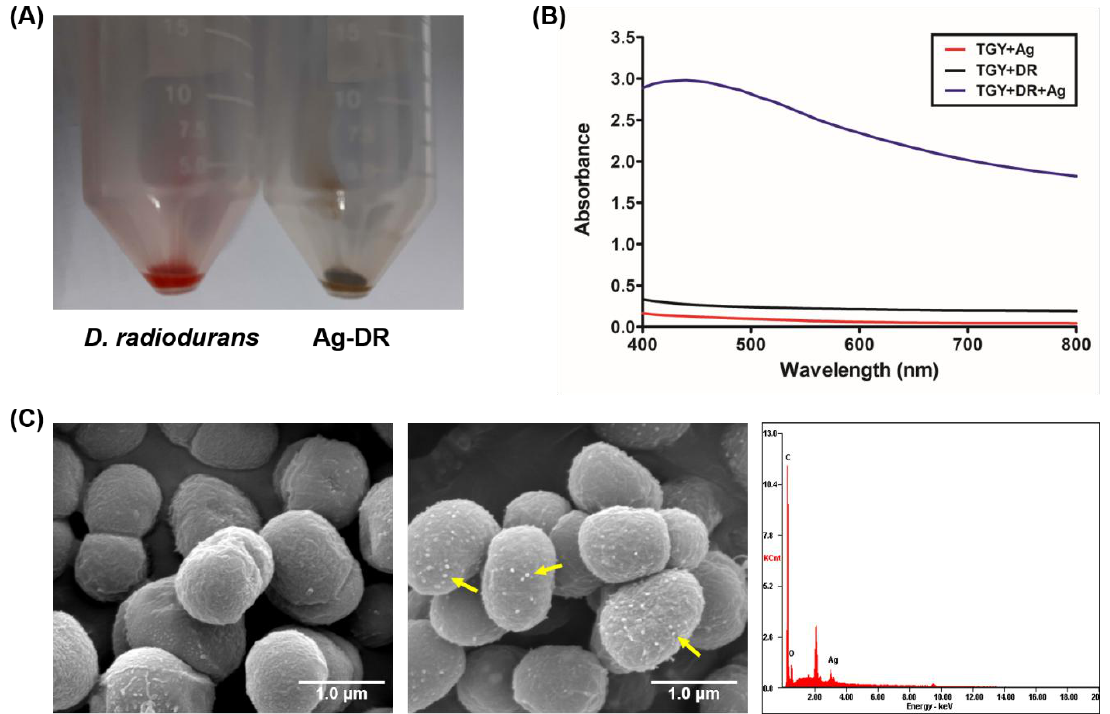
Figure 4. Characterization of Ag-DR: ( A ) Photographic image of D. radiodurans (left) and Ag-DR (right); ( B ) UV/vis spectra of D. radiodurans and Ag-DR; and ( C ) SEM image of D. radiodurans (left, 50,000 × ), Ag-DR (center, 50,000 × ), and EDX analysis of Ag-DR (right). Yellow arrows in the images indicate AgNPs on D. radiodurans .